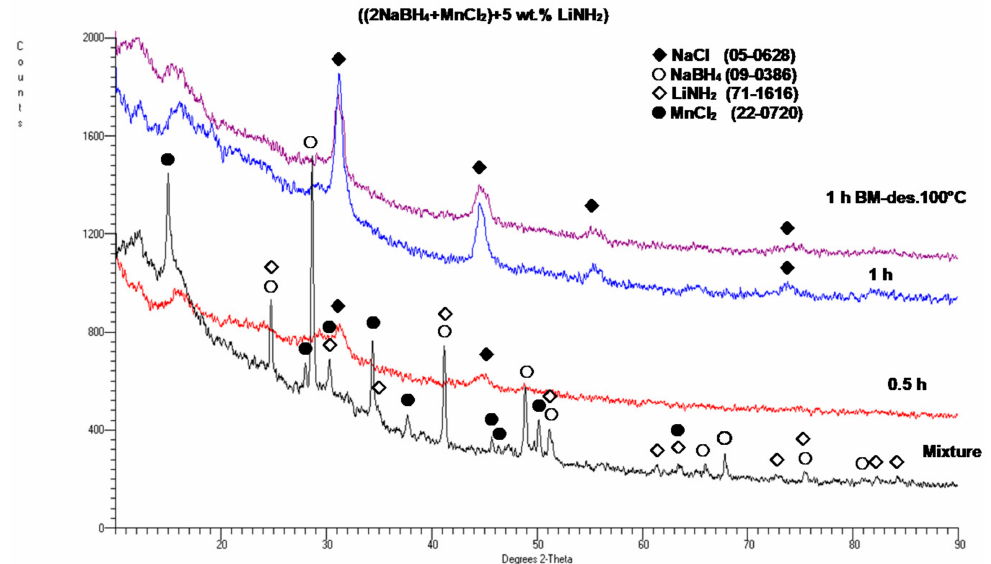
Figure 5. X-ray diffraction (XRD) patterns for the (2NaBH 4 + MnCl 2 ) + 5 wt. % LiNH 2 ), ball milled (BM) for 0.5 and 1 h and the 1 h BM sample after desorption at 100 ◦ C for 36 h, as compared to the XRD patterns for the initial mixture of reactants NaBH 4 and MnCl 2